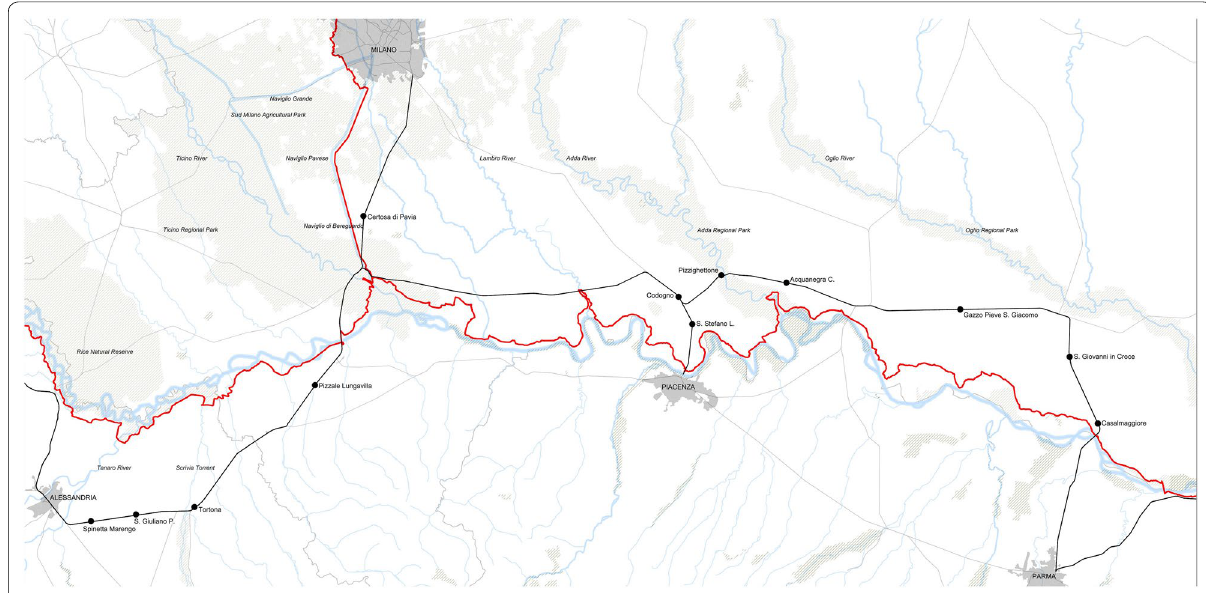
Fig. 5 Part of VENTO path considered (red) with railway (black) and stations with empty spaces available (black points). [Scale